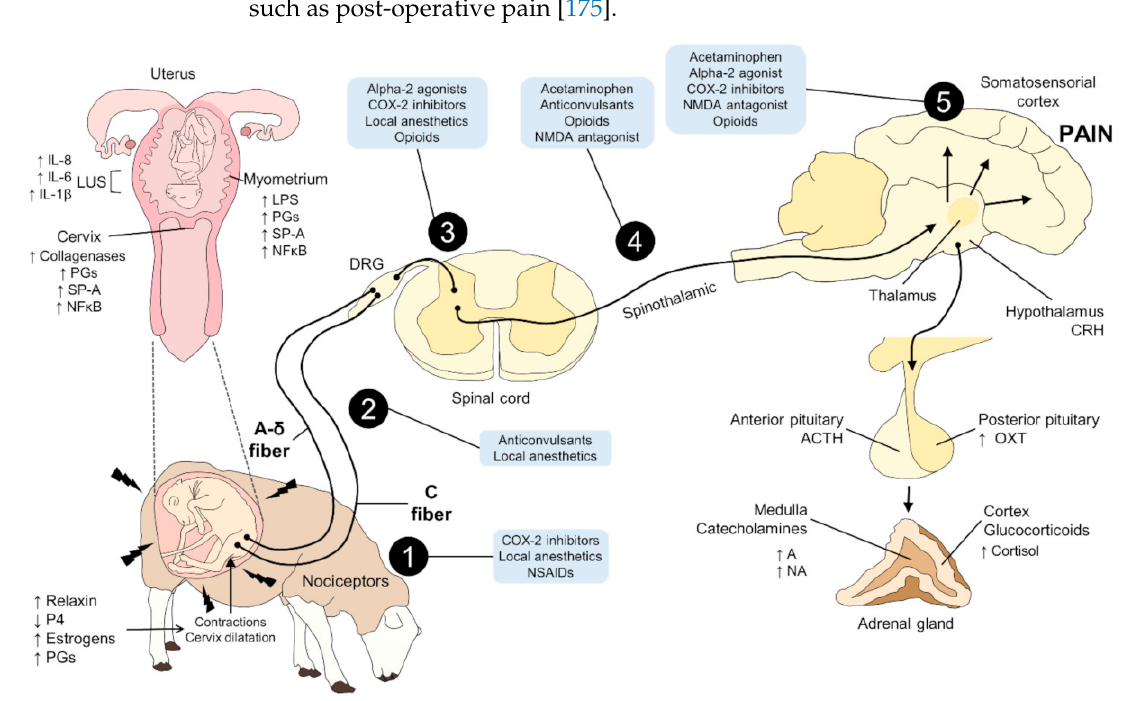
Figure 3. Sites of action of analgesics in the nociceptive pathway of parturition. During labour, hormonal factors such as increases in the concentrations of relaxin, estrogens, and PGs lead to cervical dilation and contractions. In the uterine tissue, LUS, myometrium, and cervix, different pro-inflammatory or degrading substances (such as collagenases) initiate an inflammatory response for the onset of softening and ripening the cervix. All of these factors activate peripheral nociceptors (A- δ and C fibers). These transduce the noxious stimulus into an electrical signal that is transmitted to the DRG of the spinal cord. Once in this structure, nociception modulation occurs, and drugs such as alpha-2 agonists, COX-2 inhibitors, local anesthetics, and opioids act at this site. These spinal neurons project to brain areas such as the thalamus or the somatosensory cortex, where pain perception occurs. Moreover, the activation of thalamic and hypothalamic areas leads to the secretion of other hormones such as ACTH or OXT. The adrenal gland contributes to the increase in circulating levels of A, NA, and cortisol, due to ACTH (cortisol) or by sympathetic influence (A, NA). Local anesthetics, NSAIDs, COX-2 inhibitors, opioids, acetaminophen, NMDA antagonist, and other analgesics act in each of the mentioned stages of the nociceptive pathway, depending on the nature of the drug. 1. transduction; 2: transmission; 3: modulation; 4: